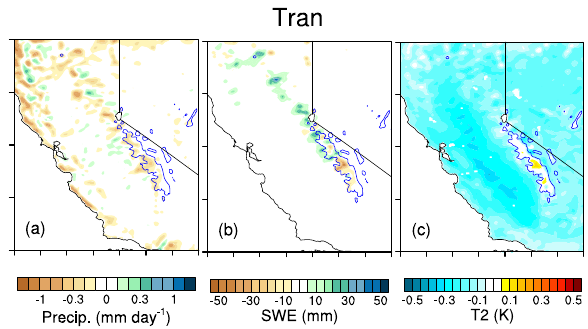
Figure 10. Effect of local anthropogenic aerosols (CTRL – NoLo- cAnth) on spatial distributions of (a) precipitation (mmday − 1 ) , (b) SWE (mm), and (c) T2 (K). Blue lines represent the mountain- tops with elevation ≥ 2.5km.